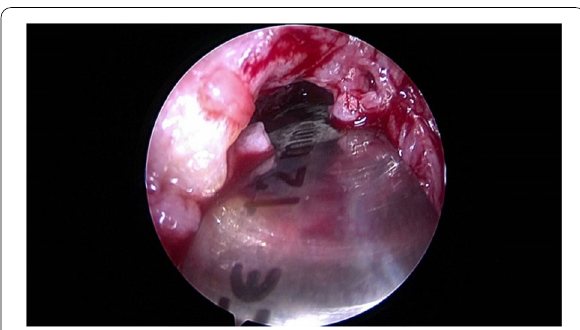
Fig. 4 Intraoperative picture showing measurement of the enlarged (12 mm diameter) tibial tunnel after removal of the